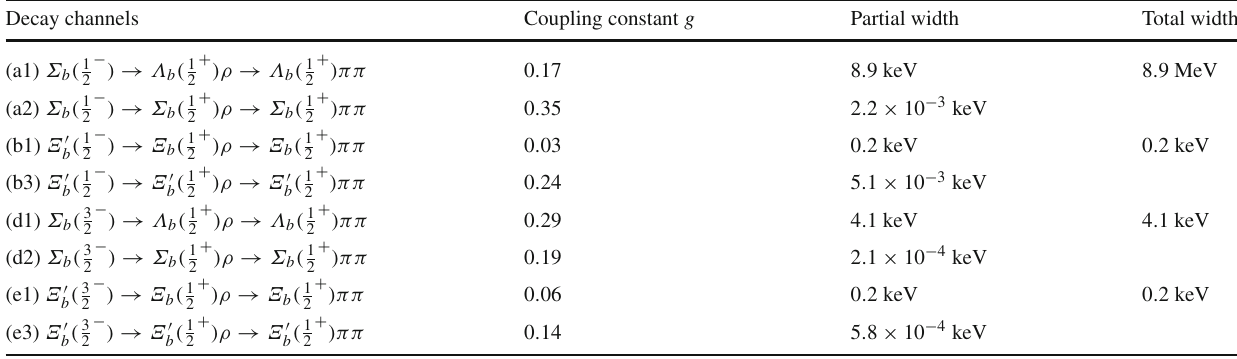
Table 1 S -wave decays of P -wave bottom baryons belonging to the doublet [ 6 F , 1 , 0 ,ρ ] into ground-state bottom baryons and vector mesons Decay channels Coupling constant g